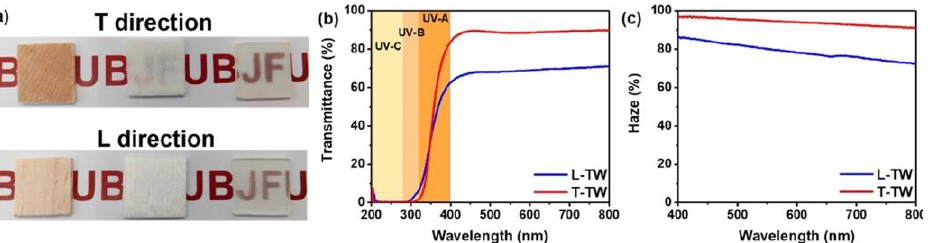
Figure 32. Optical properties of the transparent wood (TW). ( a ) From left to right, transverse (T direction) and longitudinal (L direction) digital images of wood, delignified wood, and transparent wood (thickness = 2 mm). ( b , c ) Total transmittance and haze of transverse (T-TW) and longitudinal (L-TW) transparent wood (thickness = 2 mm). Reprinted with permission from [47], copyright 2022, Elsevier.